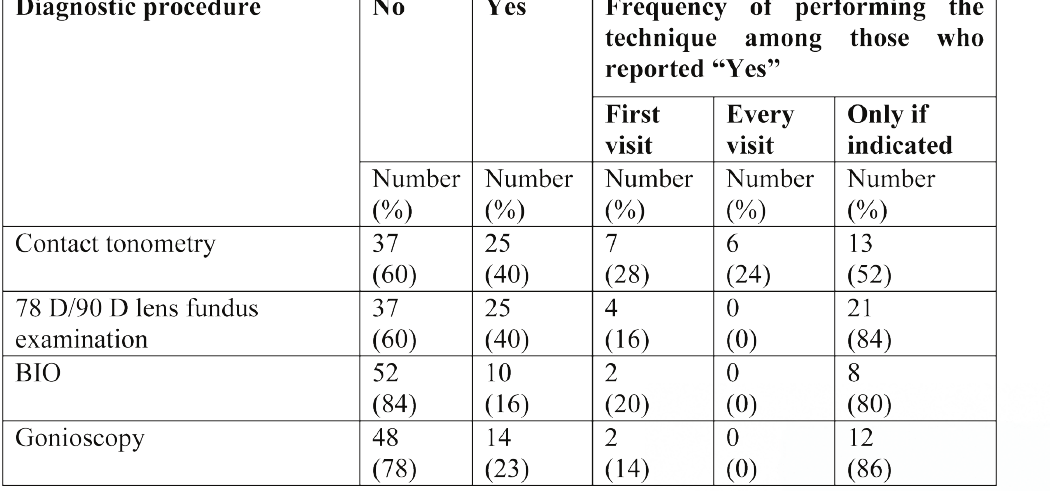
Table 1: The percentages of the optometrists using specific diagnostic procedures are provided here. Also, the frequencies of use of each procedure are shown. The most commonly practiced procedures were contact tonometry (40%) and 78 D/90 D lens fundus examination (40%) and the least was BIO